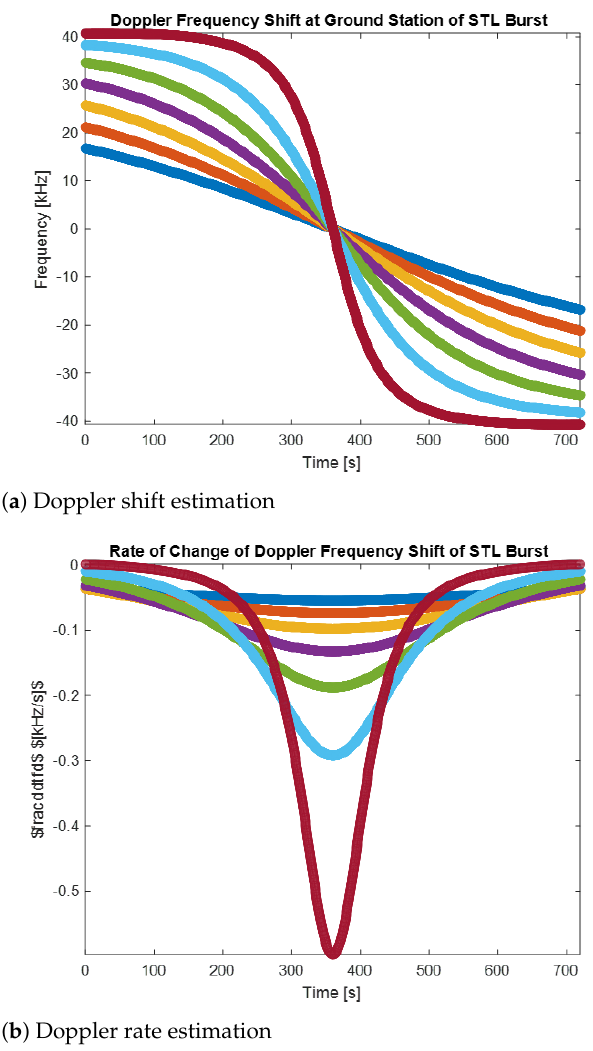
Figure 7. FDOA and DDREquivalent Doppler shift and Doppler rate estimation from real LEO satellites downlink signals: Iridium NEXT Simplex signals of opportunity